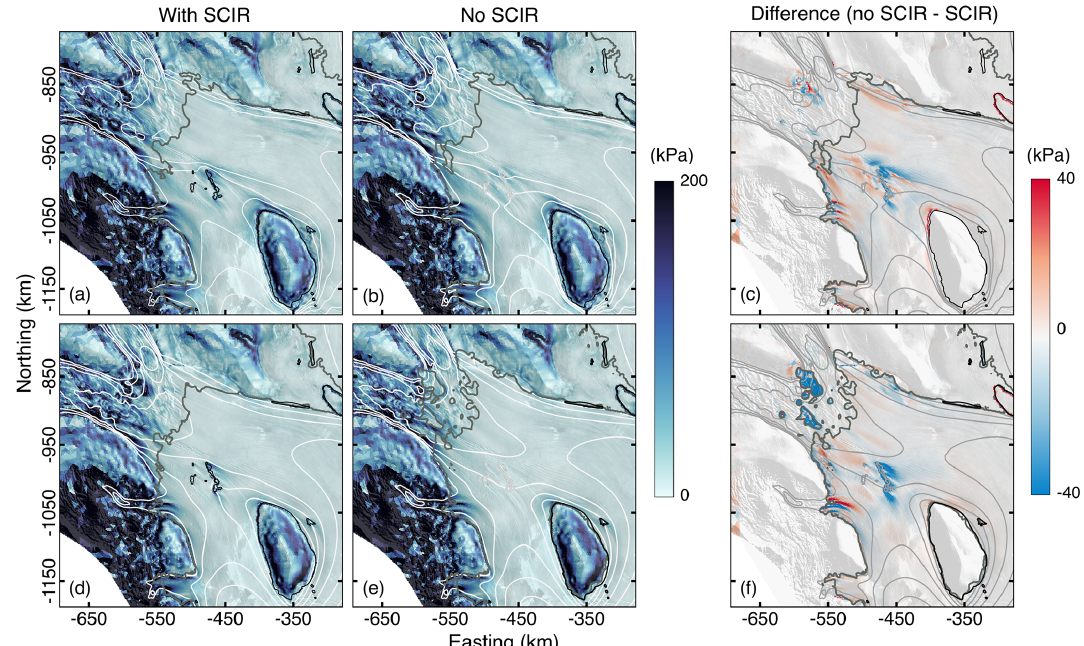
Figure 5. The gravitational driving stress τ d acting on the RIS and tributary ice streams with and without the SCIR. In panels (a) – (c) , the simulation is initialised with B inv . In panels (d) – (f) , the simulation is initialised with B u . In panels (c) and (f) , a positive (negative) change indicates an increase (decrease) in τ d after removal of the SCIR. The velocity contour lines have an interval of 100ma − 1 . Grounding-line positions in panels (a) and (d) are from the B inv and B u reference models (with SCIR). Grounding-line positions in panels (b) and (e) are from the B inv and B u perturbed models (without SCIR).